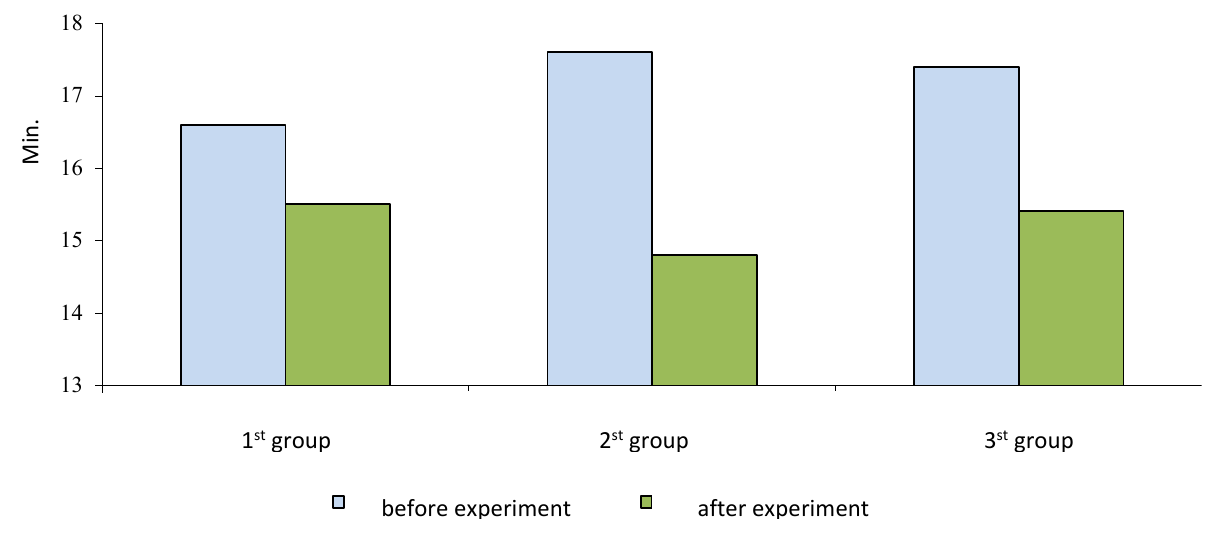
Fig.3. Indicators of endurance fitness of experimental groups’ girl students before and after experiment Analysis of repeated results in age aspect showed that character of differences changed significantly in experimental groups. For example, indicators of 1 st and 3 rd groups became much better and it was statistically confident (р <0.001). Analysis of analogous indicators of control groups did not reveal significant changes in comparison with initial